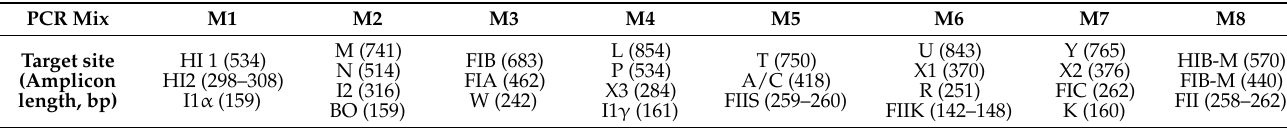
Table 2. Target sites for PBRT Amplification